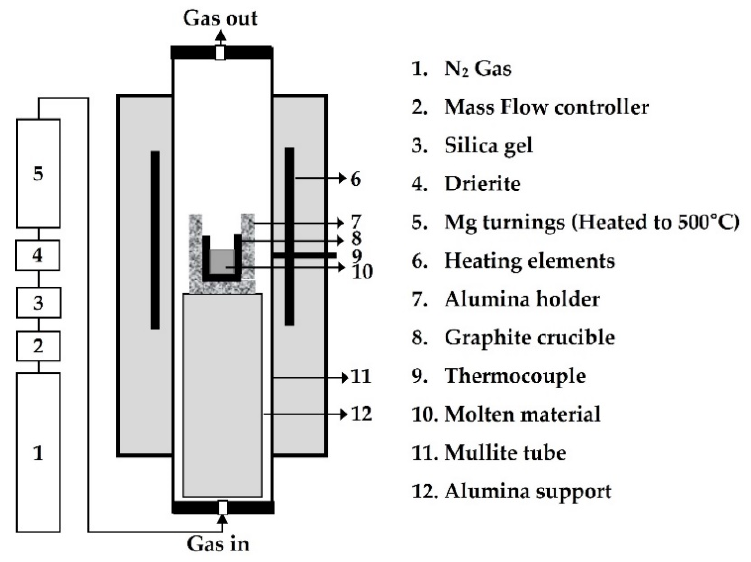
Figure 2. A schematic diagram of experimental apparatus.